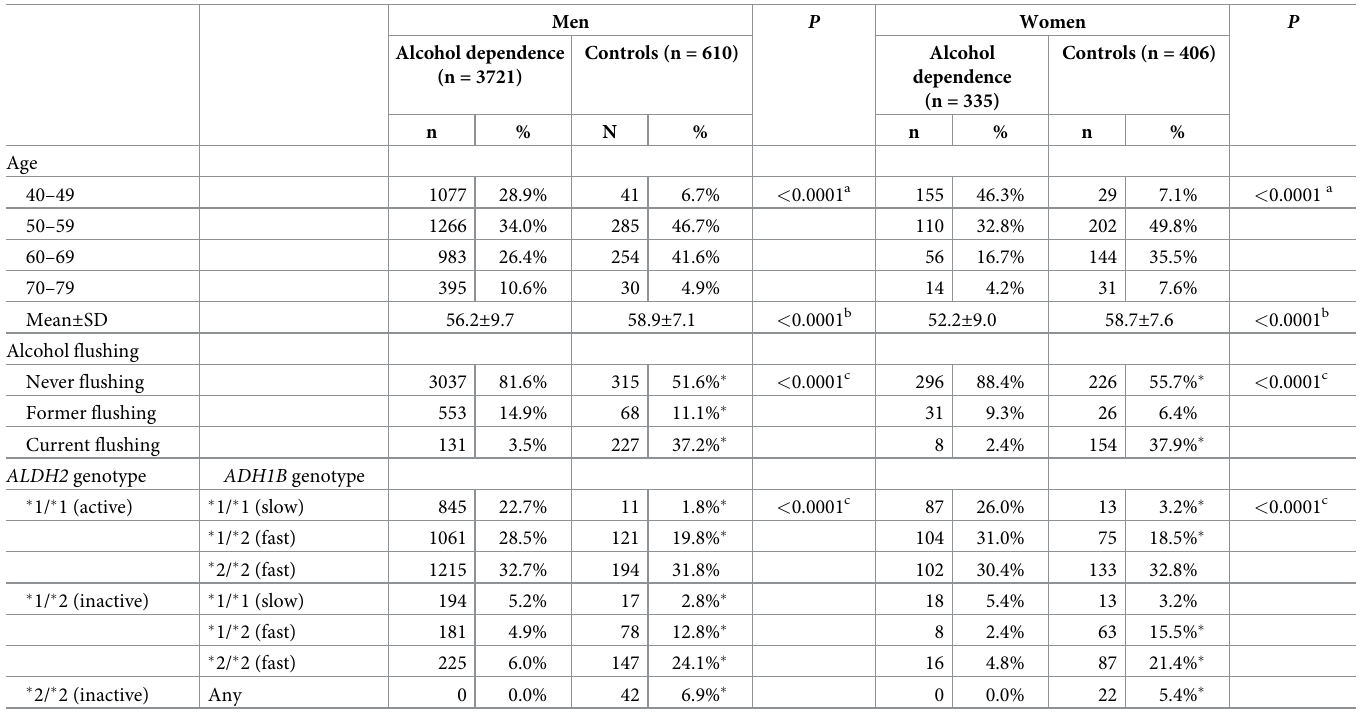
Table 1. Alcohol flushing and ADH1B and ALDH2 genotypes in the male and female